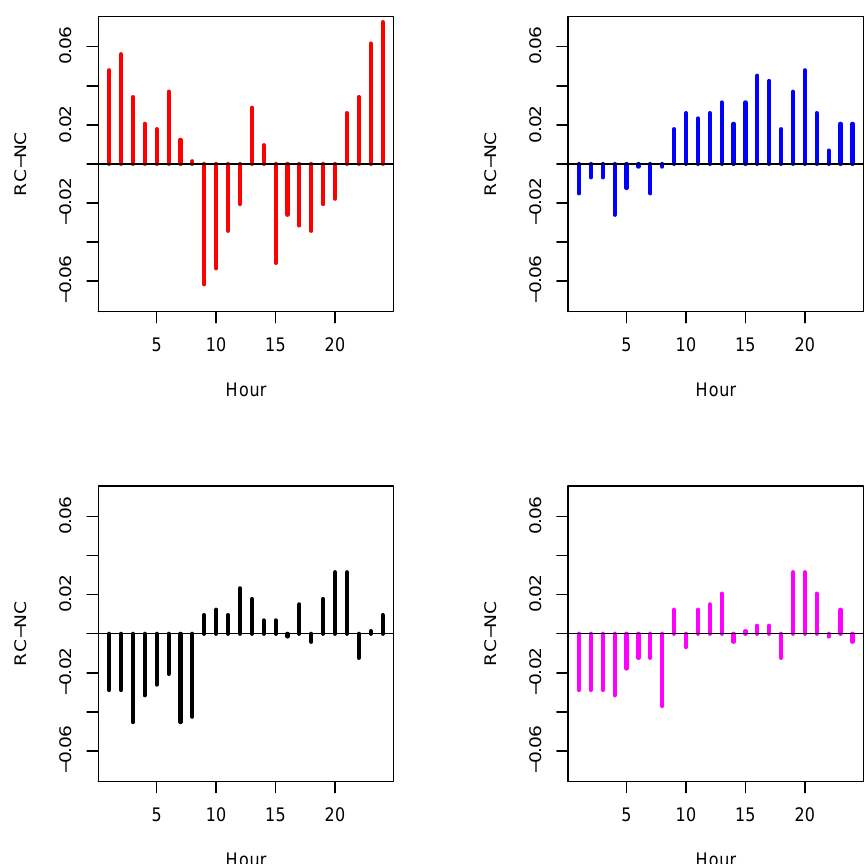
Figure 13. Differences between the nominal and observed coverage for each hour of the day for: the homoscedastic ( red ), the GARCH ( 1,1 ) –N ( blue ), the Calendar–GAM ( black ) and the Full–GAM ( magenta )